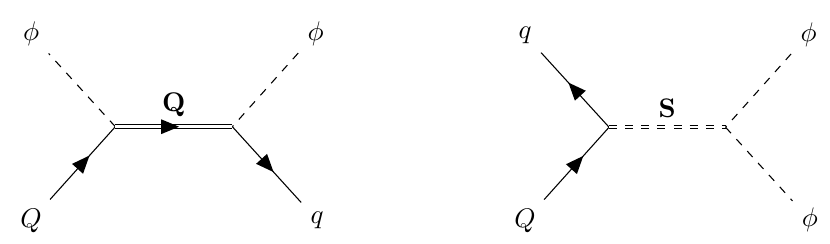
Figure 1 . Tree-level diagrams that generate the (cid:22) Qq(cid:30)(cid:30) operator in UV completions of L with additional extra quarks (left) and additional scalars (right).